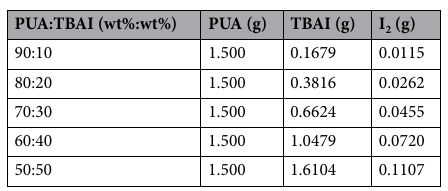
Table 1. Composition of PUA-TBAI-I 2 gel polymer